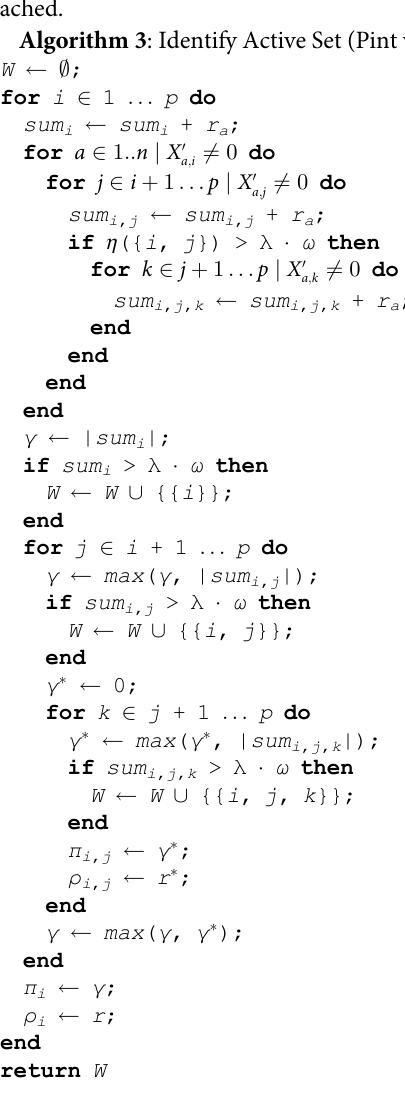
Algorithm 3 : Identify Active Set (Pint version, three-way